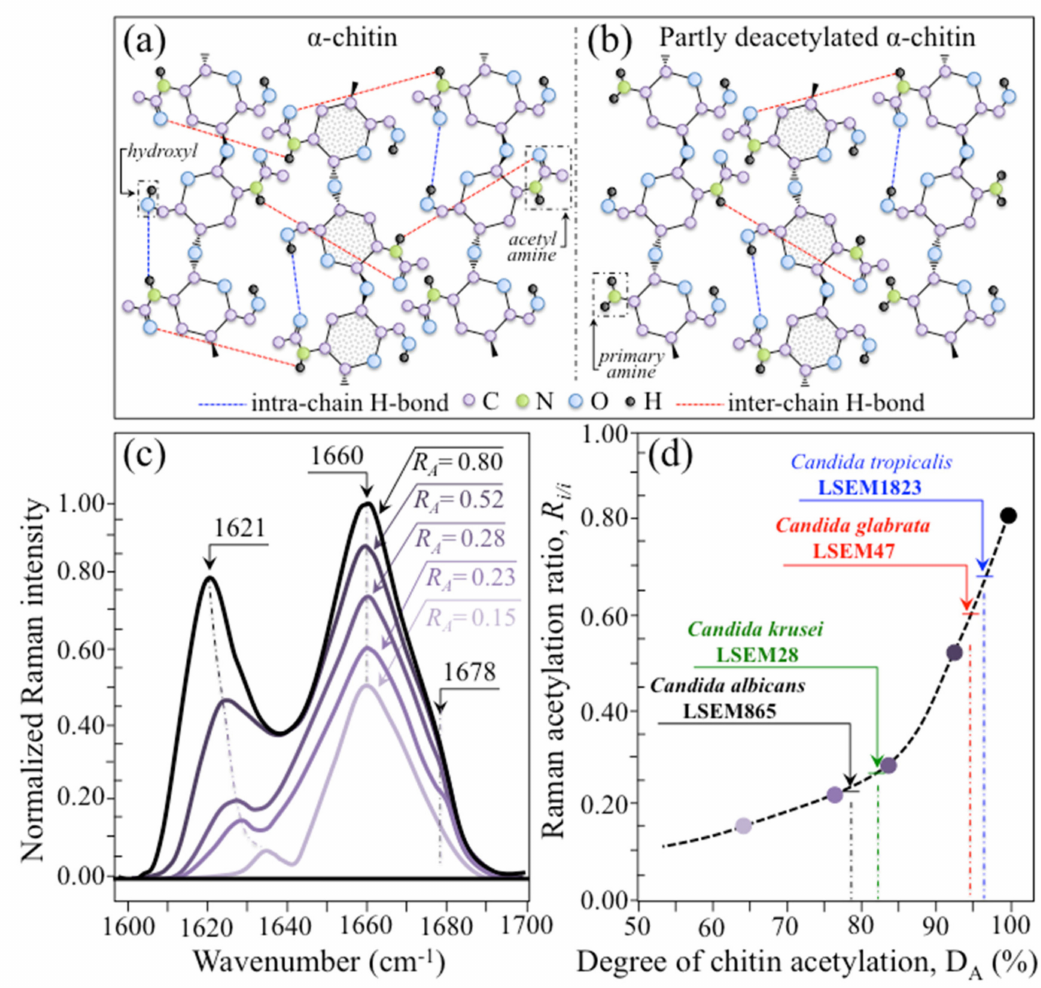
Figure 6. Structure of ( a ) fully acetylated and ( b ) partly deacetylated α -chitin crystals; ( c ) Amide I spectra of increasingly deacetylated chitin structures with their structure-dependent vibrational characteristics [72], which vary with decreasing the degree of chitin acetylation, D A (namely, the fraction of acetyl groups present in the α -chitin structure), and ( d ) calibration curve linking the Raman acetylation ratio, R i/I , to the degree of chitin acetylation, D A , according to which different Candida species were evaluated (cf.